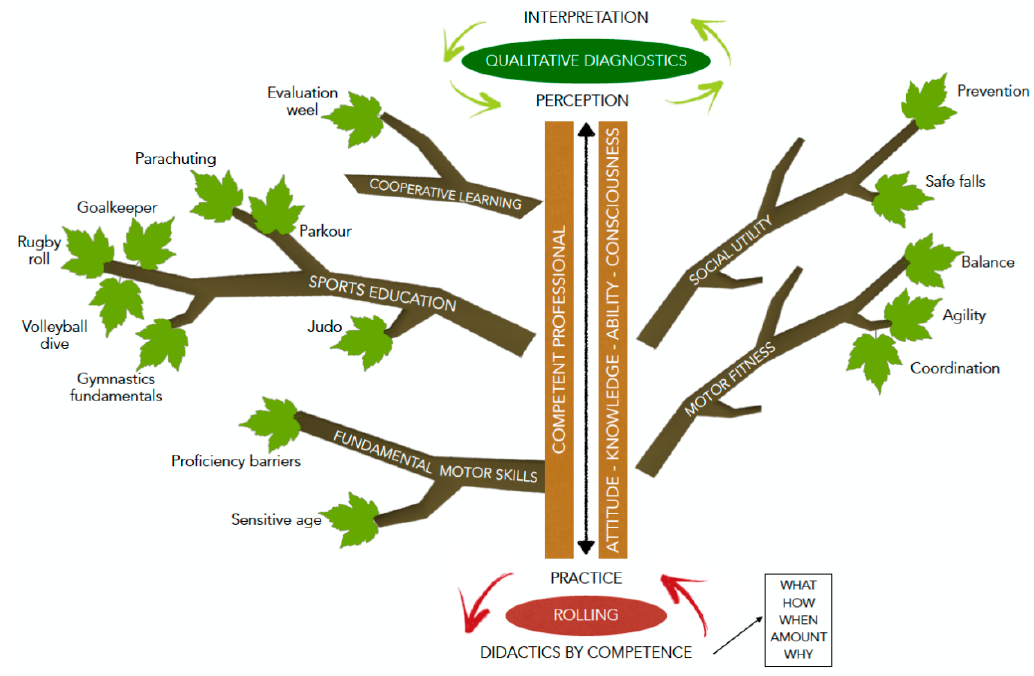
Figure A2. Allegorical representation of the features of a proficient PE teacher: “The Tree of Competence”. As in a tree, the main features of a proficient PE teacher are displayed: the skills of a competent professional (the log of the tree) allow proper management of the tasks to be learned / trained and their goals (the branches), thanks to the acquired competence to interpret / evaluate their outcomes (the top), which is strengthened by individual experiences and consciousness (the roots).